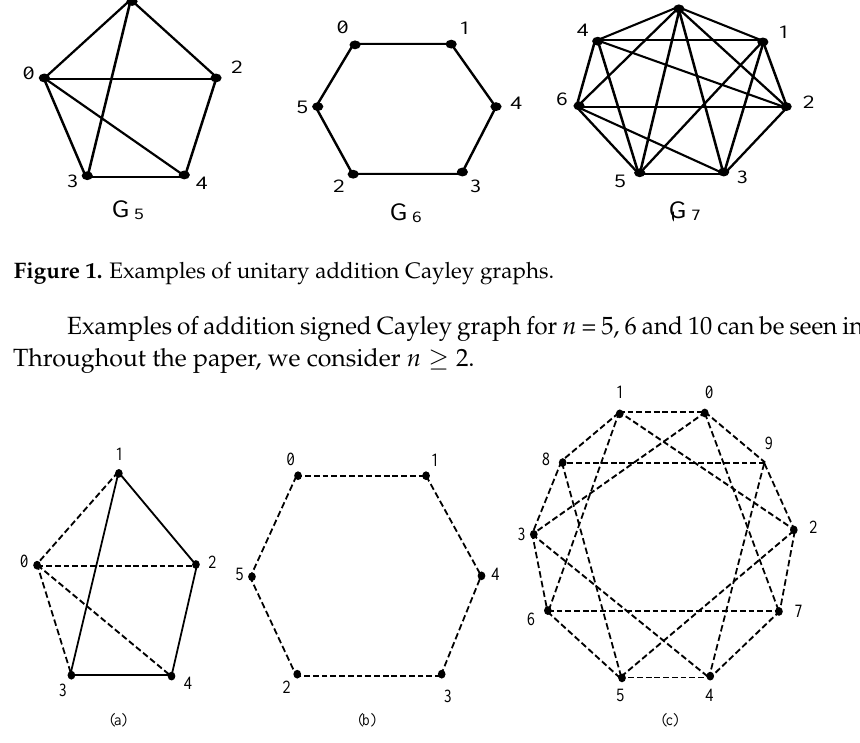
Figure 2. Examples of addition signed Cayley graph Σ ∧ n